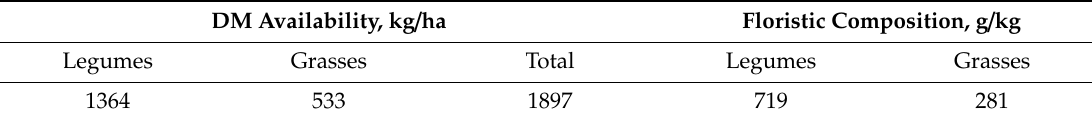
Table 1. Herbaceous stratum availability, expressed as DM (Dry Matter), and floristic composition of Caatinga -native pasture in the rainy